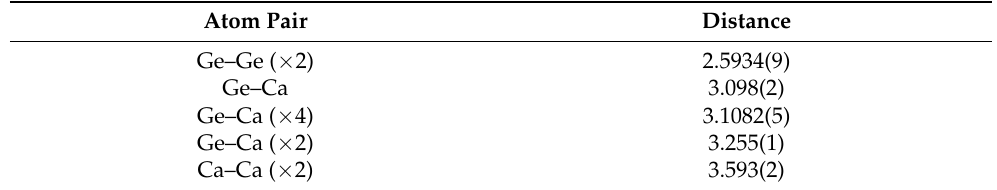
Table 3. Selected interatomic distances (Å) in CaGe. Only the shortest Ca–Ca contacts are shown, the rest are 3.9 Å and